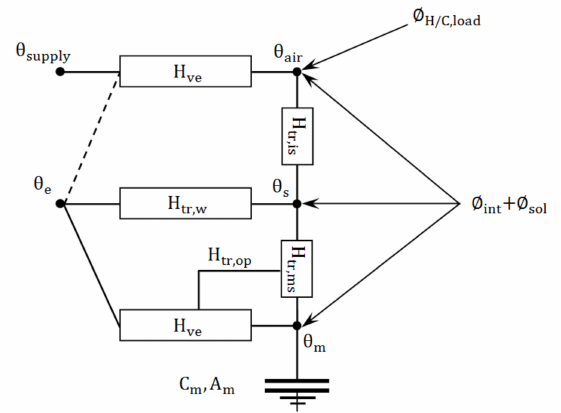
Figure 4. Schematic drawing of the 5R1C resistance-capacitance model showing the heat transfer between the internal and external